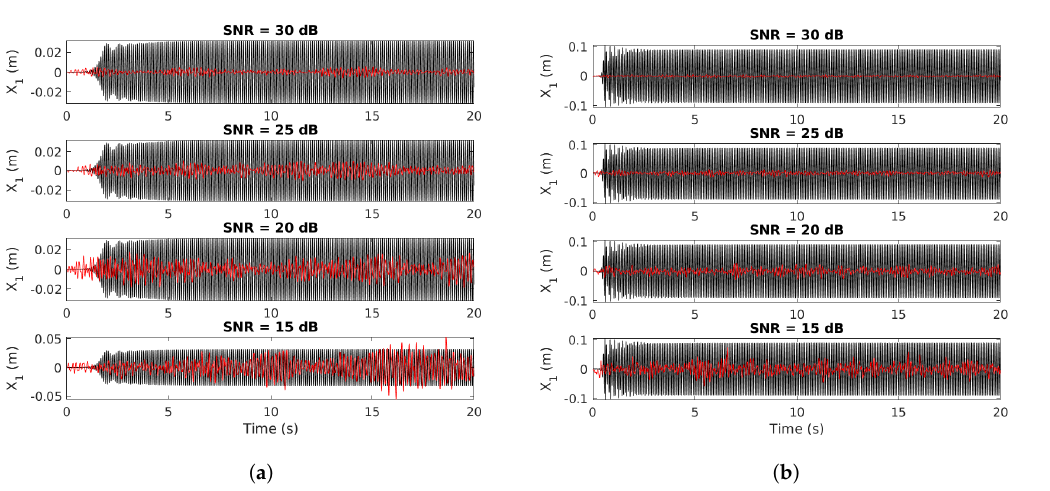
Figure 12. Influence of the signal-to-noise ratio (SNR) on control performances on X 1 ( uncontrolled; controlled). ( a ) µ = 0.4 ( b ) µ =